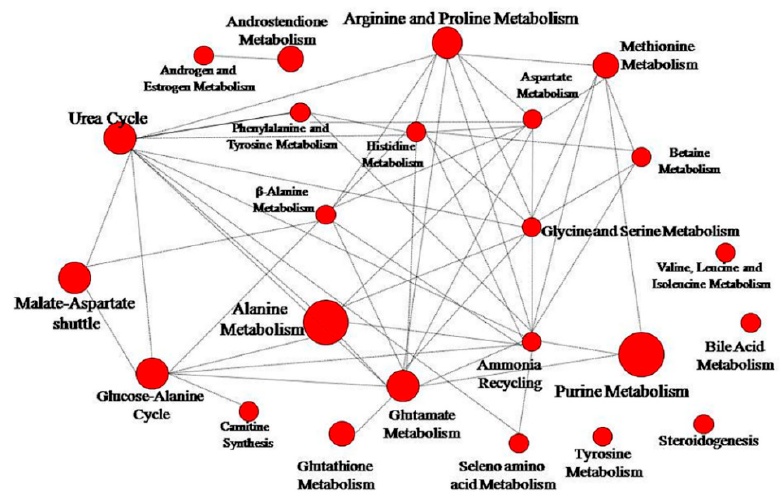
Figure 6. Network pathway visualization analysis. Higher size of the nodes reflects higher level of relevance for each pathway.